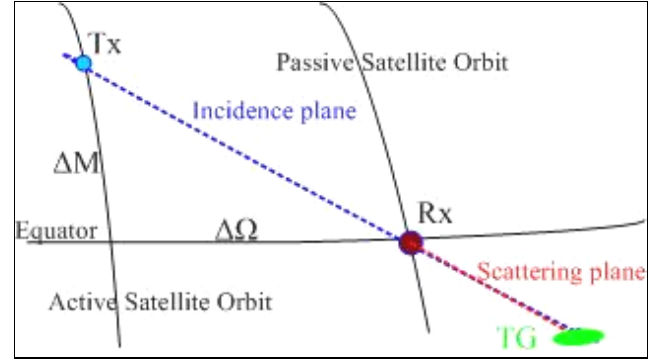
Figure 3. Relative position of the satellites at the initial epoch ( γ is the yaw-steering angle of the active